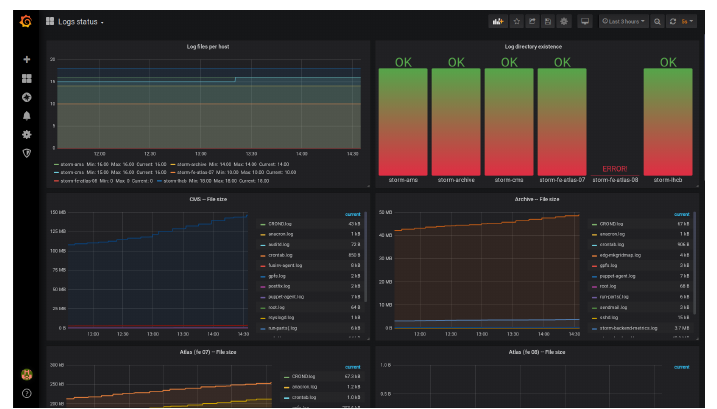
Figure 3. Grafana dashboard to monitor the status of the Big Data